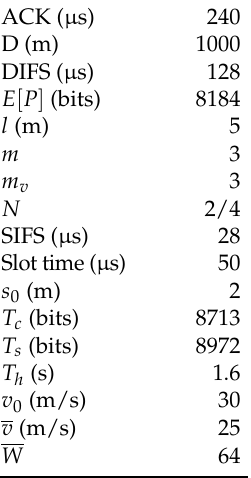
Table 2. Simulation parameter